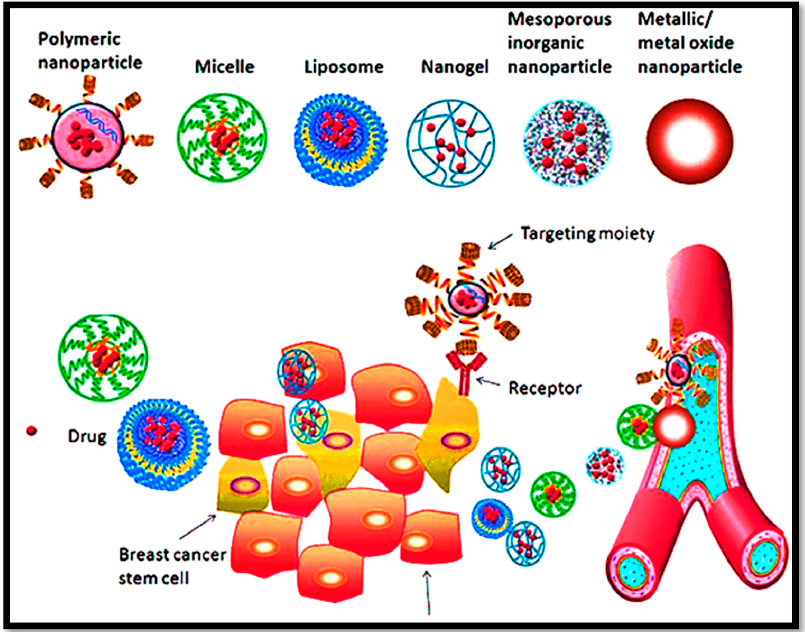
Figure 3. The proficiency of multifunctional nanocargoes for their versatility and expected clinical impact in BC management.